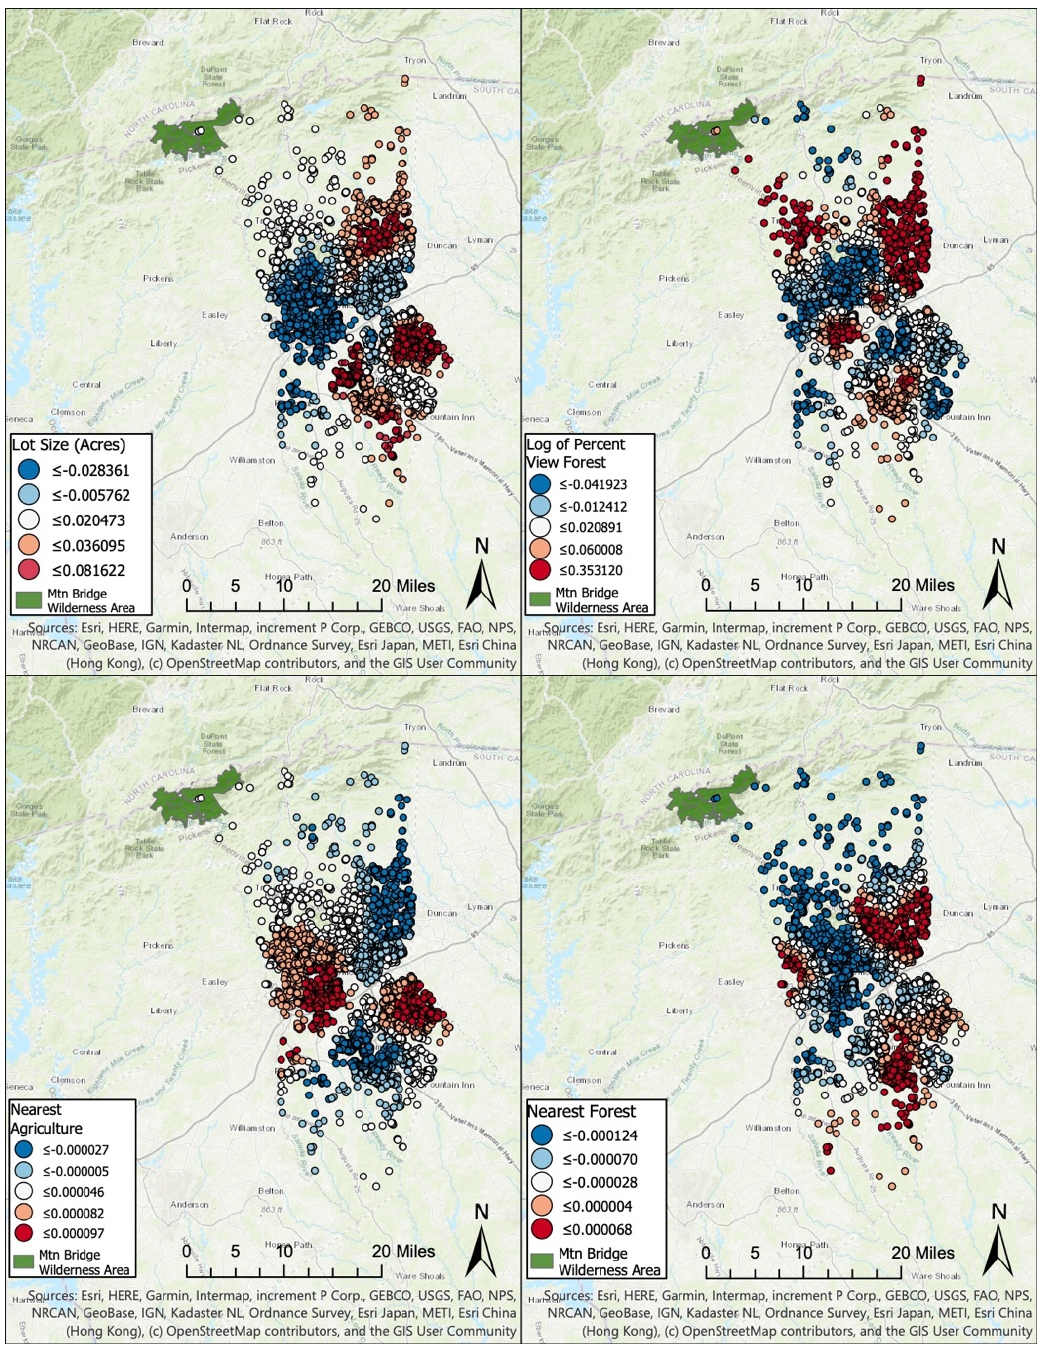
Figure 3. GWR coe ffi cient estimates for lot size, log of percent view of forest, nearest agriculture, and